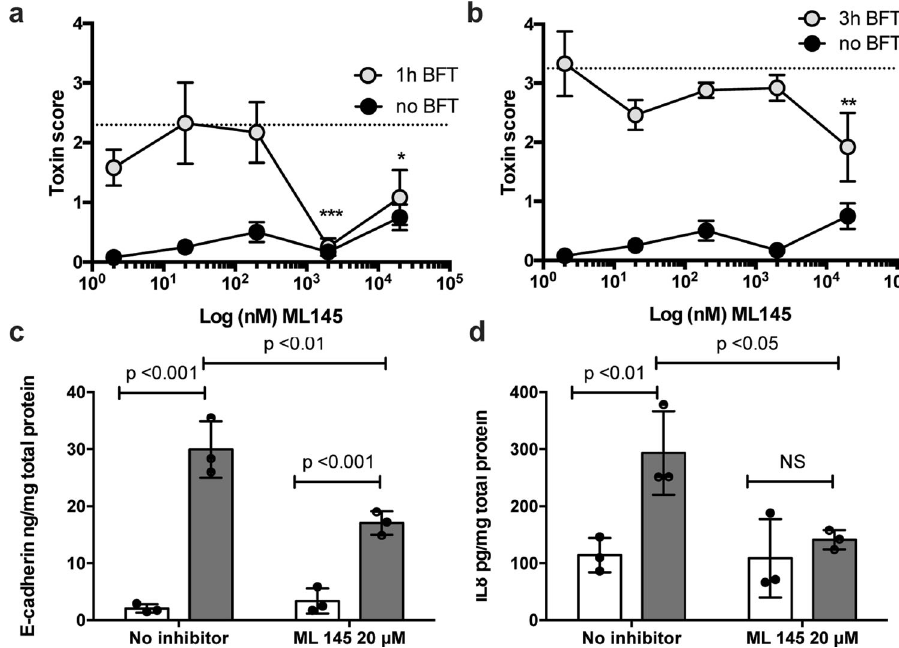
Fig. 2 The GPR35 antagonist ML145 inhibits CEC response to BFT in HT29/c1 cells. HT29/c1 cells were treated for 1 h ( a ) and 3 h ( b ) with BFT and increasing concentrations of the GPR35 antagonist ML145 ( N = 3). Treatment with ML145 signi fi cantly inhibited changes in HT29/c1 cell morphology (two-way ANOVA P = 0.023 and P = 0.015, 1h ( a ) and 3 h ( b ), respectively) compared to the positive control (BFT without antagonist — dotted lines). Treatment with 2 and 20 µ M of ML145 inhibited BFT morphological changes at 1h and 20 µ M ML145 at 3 h (Dunnet ’ s multiple comparison test * P < 0.05, ** P < 0.01, *** P < 0.001). c BFT treatment signi fi cantly enhanced the release of E-cadherin into the culture supernatant ( P < 0.001). E-cadherin release was signi fi cantly inhibited by ML145 ( N = 3, P < 0.01). d BFT treatment signi fi cantly enhanced IL-8 secretion into the culture supernatant ( P < 0.01). IL-8 secretion was signi fi cantly inhibited by ML145 ( N = 3, P < 0.05; two-way ANOVA with Bonferroni post test in c and d